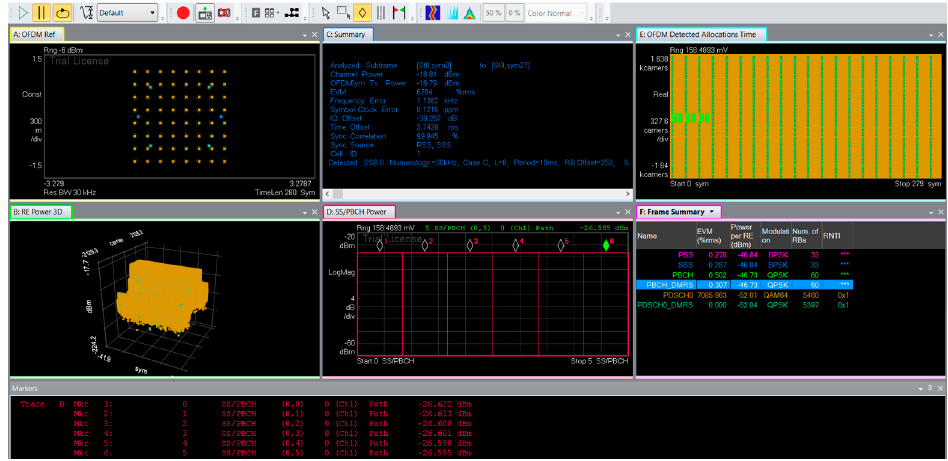
Figure 8. Screenshot of the 5G demodulation software with many relevant characteristics of the detected signal #1, such as the In-phase and Quadrature (IQ)diagram, the carrier vs. time allocation map, and the detected power level for control channels, data channels, and SS-Blocks.